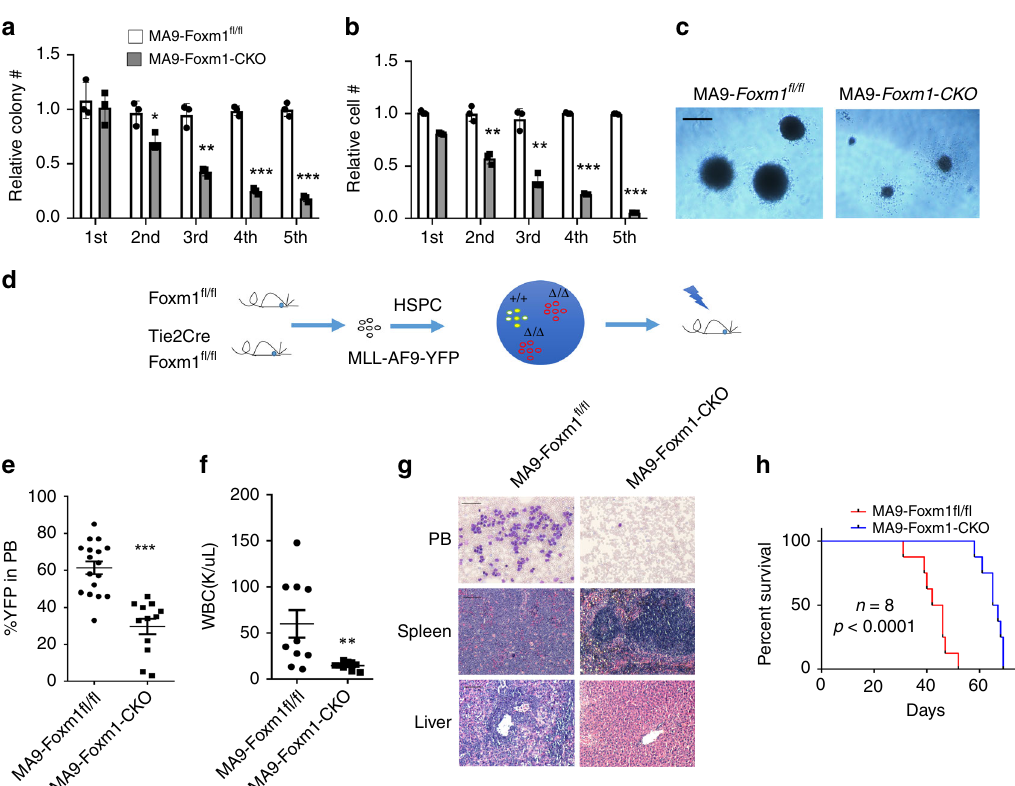
Fig. 2 Foxm1 loss delays the development of AML induced by MA9 in vivo. a The relative number of colony-forming units. b The relative number of cells. c Representative images of the colonies for the 5 th round of plating are displayed. The MA9 infected Foxm1 CKO or control (Foxm1 fl / fl ) Lin − BM cells were resuspended and replated weekly in methocult TM medium containing cytokines, bar = 100 μ M. d Schematic diagram for generation of MA9-induced Foxm1 fl / fl and Foxm1 fl / fl -CKO AML mouse models. e Flow cytometric analysis of engraftment of YFP + cells from MA9-Foxm1 fl / fl or MA9-Foxm1-CKO